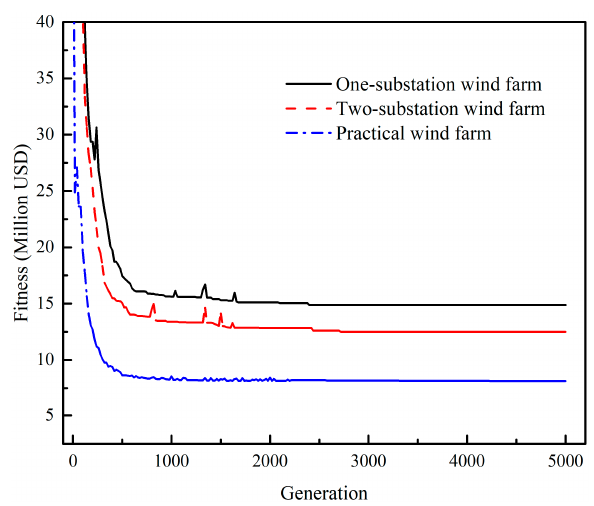
Figure 13. Convergence curves for the proposed